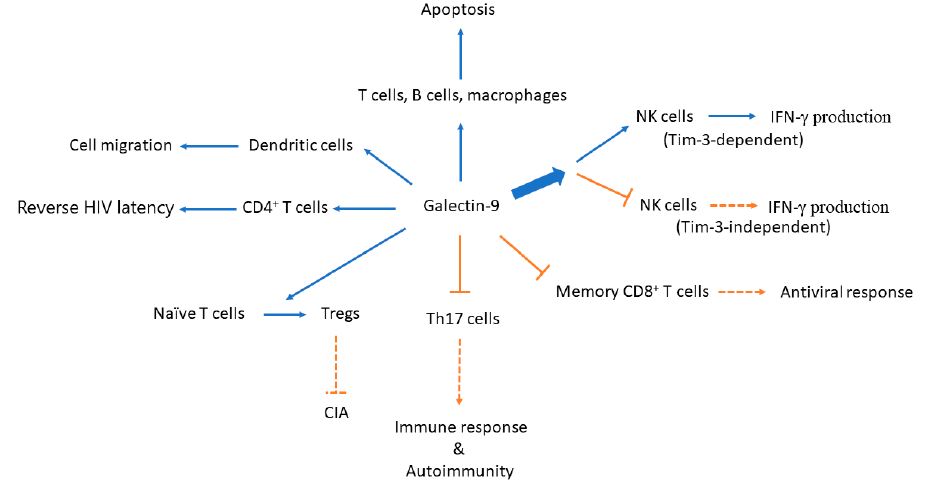
Figure 1. A simplified diagram illustrates the effects of galectin-9 on immune cells and the potential consequences. Expression of a proteolysis-resistant galectin-9 construct induces apoptosis in immune cells as well as in malignant cells. Galectin-9 causes the differentiation of naive T cells to Tregs and inhibits differentiation towards T helper (Th)17 cells. Both effects lead to the inhibition of the development of immune response and autoimmune arthritis in a CIA animal model. While treatment with recombinant human galectin-9 induces IFN- γ production in a Tim-3-overexpressing NK cell line and in Tim-3 + primary NK cells induced with low-dose IL-12 and IL-18, galectin-9 ligation has also been shown to reduce the proportion of IFN- γ -producing NK cells stimulated with IL-12/IL-15 in a Tim-3-independent manner. Galectin-9 treatment extensively regulates gene expression of molecules involved in the processes of human immunodeficiency virus (HIV) latency. Galectin-9 may also regulate dendritic cell migration in the example of dengue virus (DENV) infection. NK, natural killer; CIA, collagen-induced arthritis; IFN- γ , interferon- γ ; and, Tregs, regulatory T cells. Blue arrow: bold blue arrow: simply means there are two diverging effects out of this direction; orange T-bar induce; bold blue arrow: Simply means there are two diverging effects out of this direction; orange T- arrow/orange dotted T-bar arrow: inhibit; orange arrow with dotted line: bar arrow: inhibit; orange arrow with dotted line: reduce; orange dotted T-bar arrow: inhibit Suggestion: For simplicity, the only orange dotted T-bar arrow can be converted to orange T-bar arrow (same meaning).